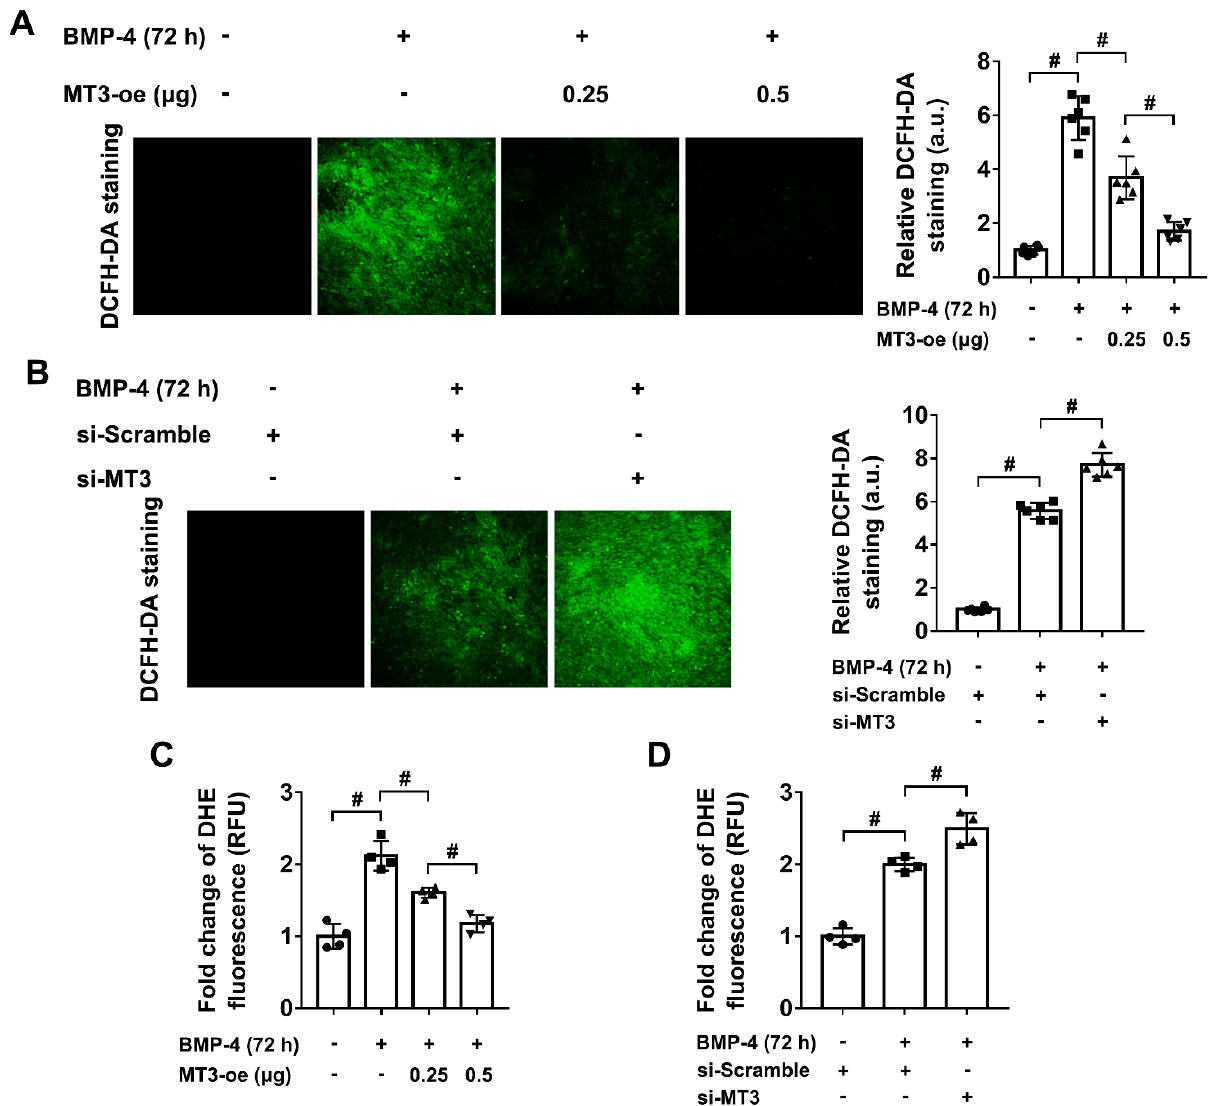
Figure 5. MT3 reduces oxidative stress in BMP4 treated C2C12 cells. ( A ) DCFH-DA staining and quantitative analysis of ROS production in control or MT3-overexpressing C2C12 cells treated with or without recombinant BMP4 for 72 h (magnification = 100 × ). Green color represents the fluorescence intensity of DCFH-DA staining. ( B ) DCFH-DA staining and quantitative analysis of ROS production in control or MT3 knockdown C2C12 cells treated with or without recombinant BMP4 for 72 h (magnification = 100 × ). ( C ) Quantitative analysis of DHE fluorescence in control or MT3-overexpressing C2C12 cells treated with or without recombinant BMP4 for 72 h. ( D ) Quantitative analysis of DHE fluorescence in control or MT3 knockdown C2C12 cells treated with or without recombinant BMP4 for 72 h. All data are presented as mean ± SEM, # p <